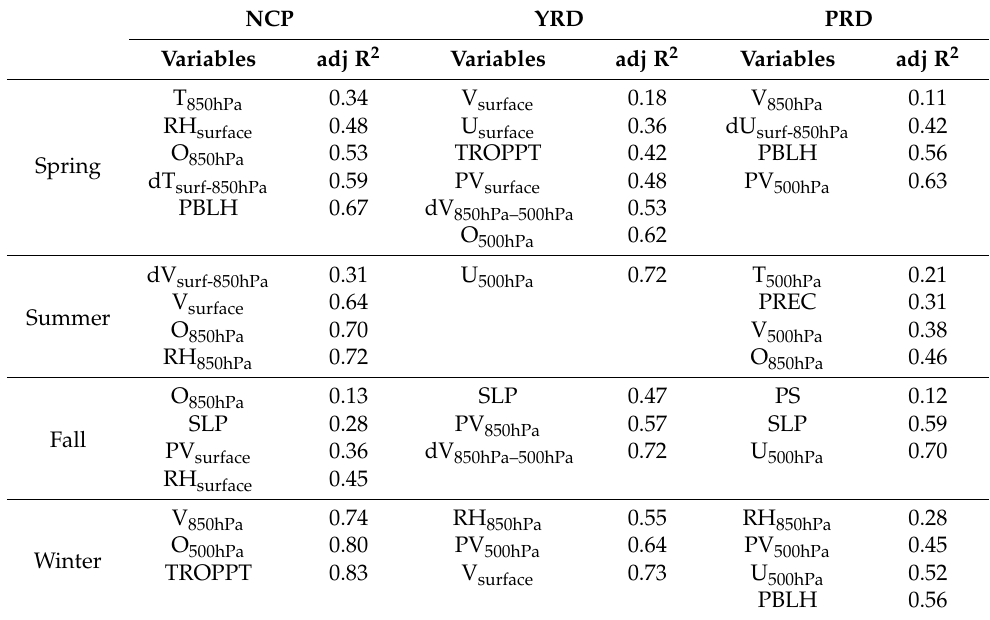
Table 2. Meteorological parameters that explain the AOD variations in NCP, YRD, and PRD in different